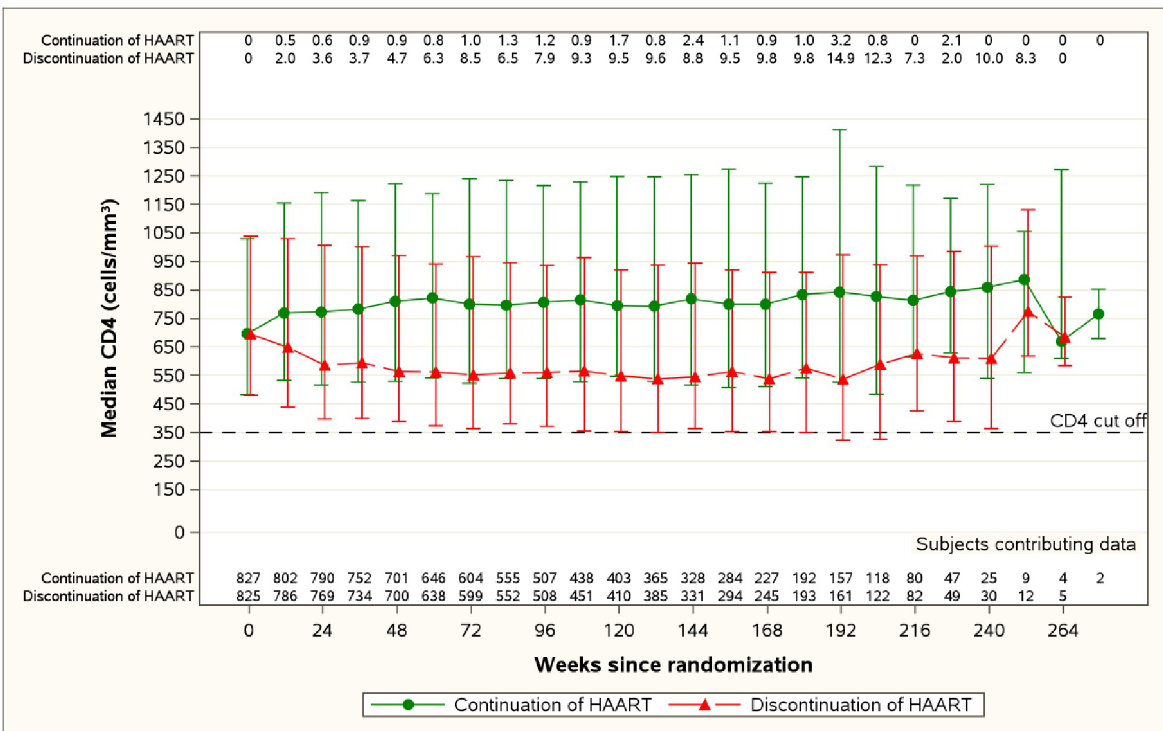
Fig 3. CD4 Cell Counts Over time (Median, 10 th and 90 th percentile, and the proportion < 350 cells/mm). The median CD4 cell counts in the continue (green)and discontinue (red) arms are show at each follow-upvisit. The proportionwith a CD4 count below350 cells/mm3 are shown across the top of the figure at each